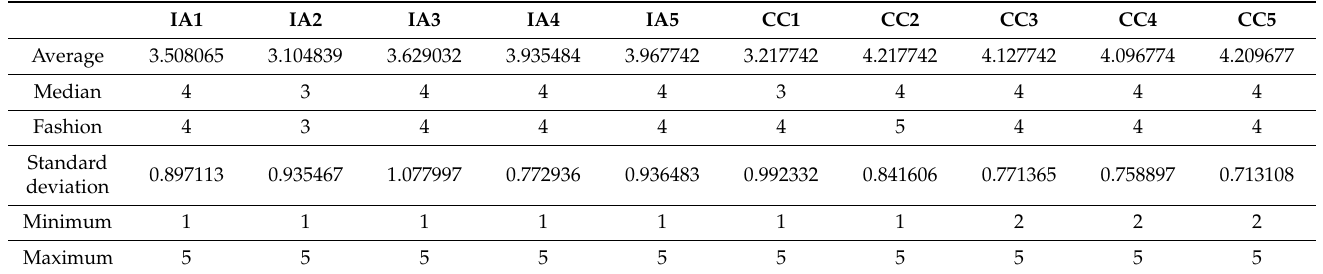
Table 8. Analysis of the data